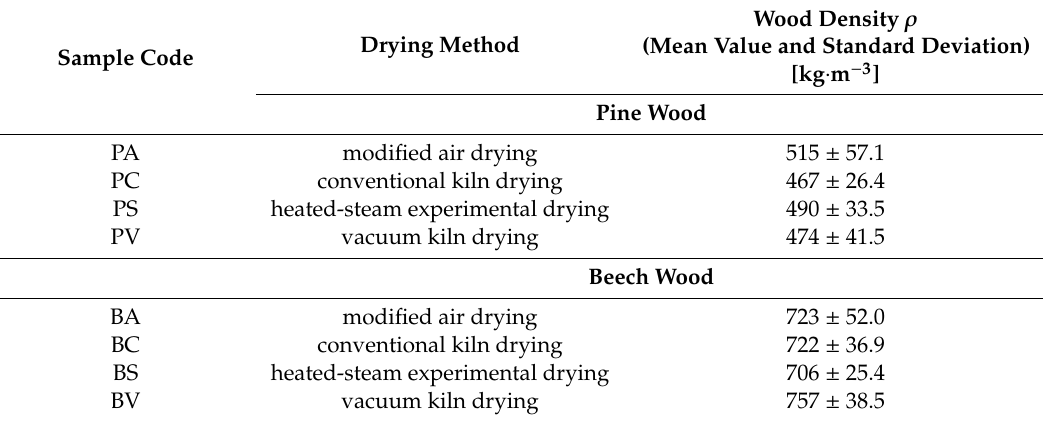
Table 1. Density of tested pine and beech wood